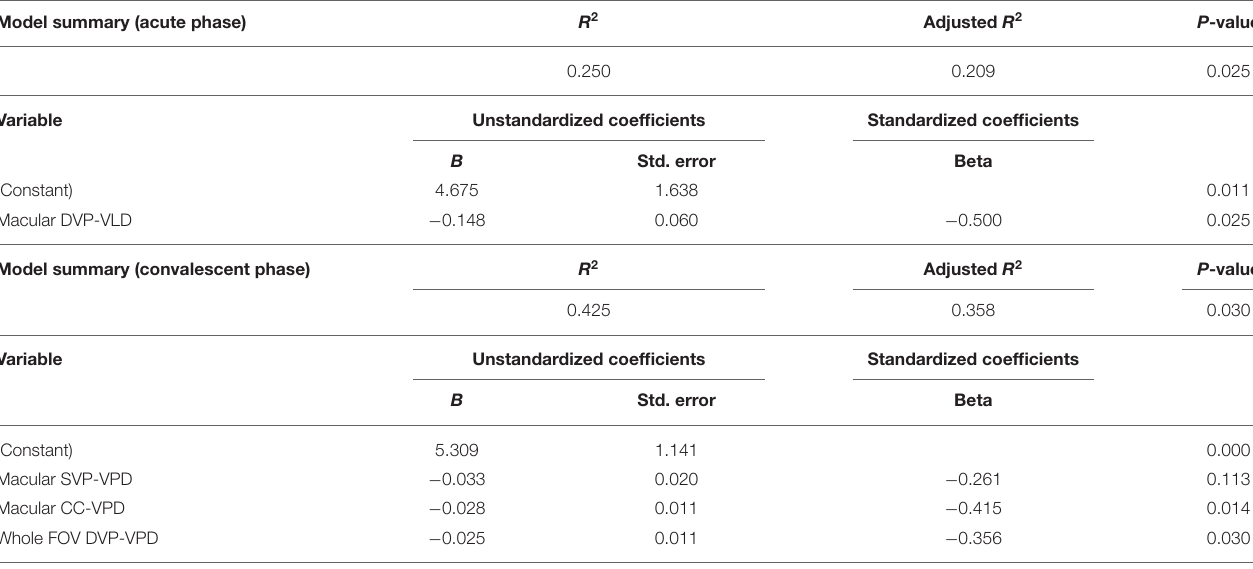
TABLE 6 | Stepwise Multiple Linear Regression Analysis for the Predictors of LogMAR